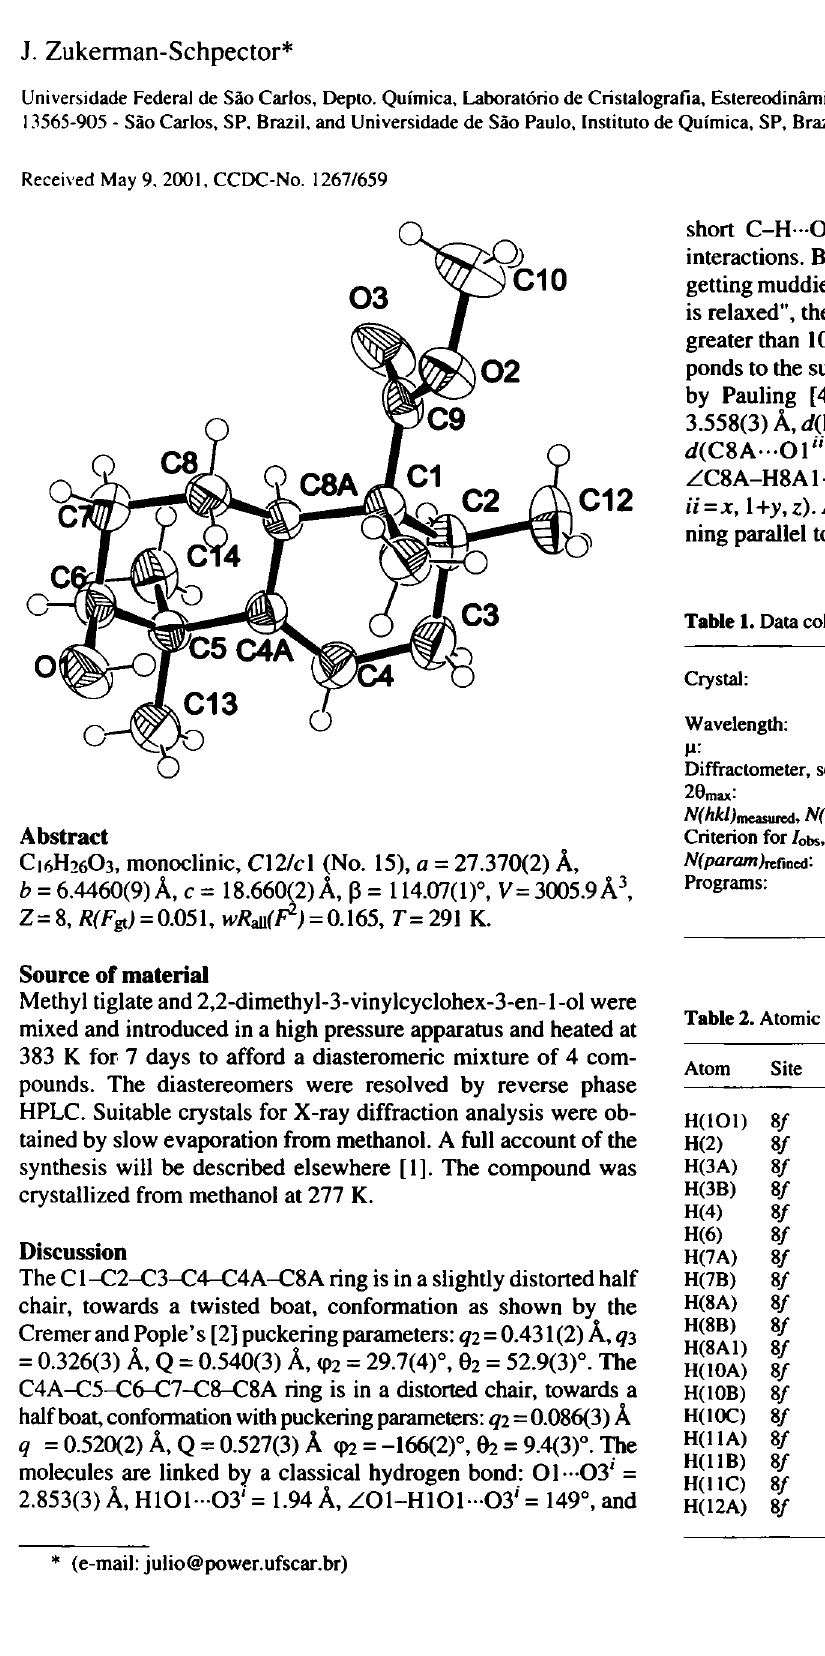
Table 2. Atomic coordinates and displacement parameters (in A 2